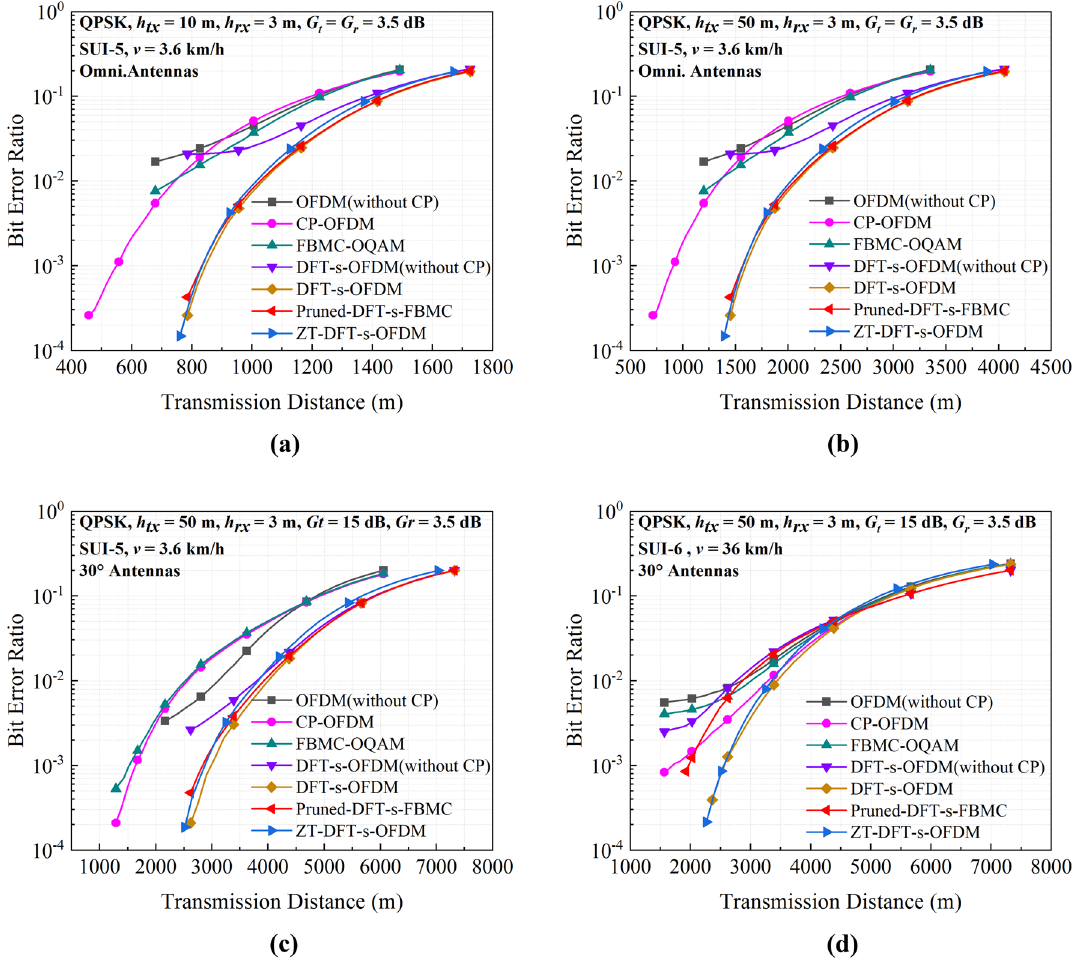
Figure 7. Simulated link BER performance versus the transmission distance for the cases of: ( a,b ) are the BER performance when the transmitting antenna height is 10 m and 50 m, respectively. ( c ) Shows the performance of the15 dB gain antenna. ( d ) Changes the SUI-6 sub-channel model and the speed to 36 km/h of the UAV.